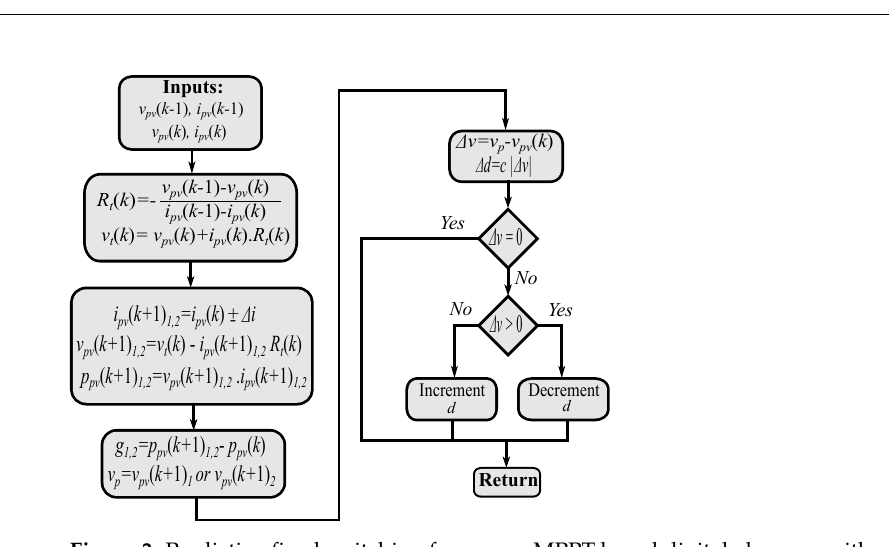
Figure 3. Predictive fixed switching frequency MPPT based digital observer without PI